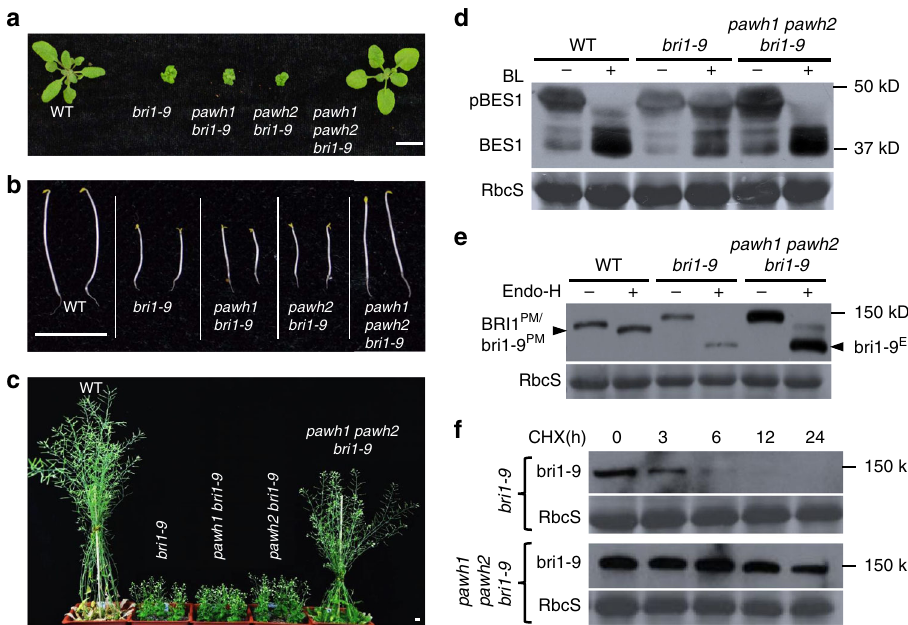
Fig. 3 Mutating two PAWHs suppresses the bri1-9 phenotype and inhibits bri1-9 degradation. a – c Photographs of 3-week-old light-grown seedlings ( a ), 7-day-old dark-grown seedlings ( b ), and 2-month-old mature soil-grown plants ( c ). Scale bar = 1 cm. d – f Immunoblot analysis of BR-triggered BES1 dephosphorylation ( d ), the Endo H sensitivity of BRI1/bri1-9 ( e ), and the protein stability of bri1-9 ( f ). Total proteins were extracted from 10-day-old Arabidopsis seedlings treated with ( + ) or without ( − ) 1 μ M brassinolide (BL, the most active member of the BR family) for 1 h ( d ) or 180 μ M CHX ( f ) for indicated durations. Proteins extracted from non-treated seedlings were treated with ( + ) or without ( − ) Endo H ( e ). These protein samples were separated by SDS-PAGE and analyzed by immunoblotting with antibodies to BES1 ( d ) or BRI1 ( e , f ). The lower strips in d – f showing the Ponceau Red- stained small subunit of the ribulose-1,5-bisphospate carboxylase/oxygenase (RbcS), were used as loading controls. The positions of the molecular mass standards are shown on the right. In e BRI1 PM /bri1-9 PM and bri1-9 ER denote BRI1/bri1-9 proteins localized on the PM and in the ER, respectively. Source data are provided as a Source Data fi